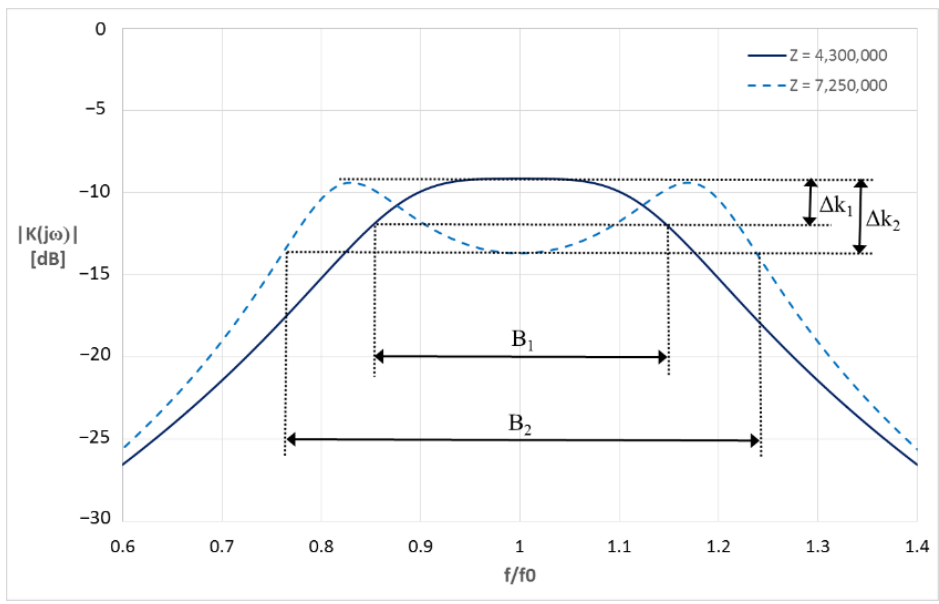
Figure 3. Relationship between the bandwidth and the unevenness of the characteristics.